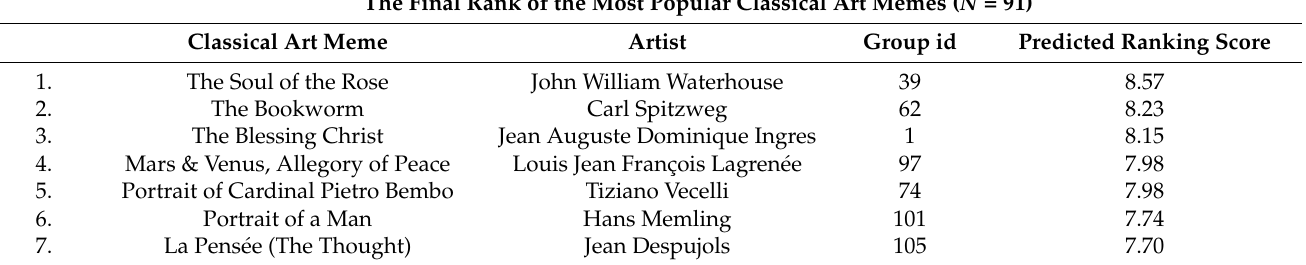
Table 5. The top 7 of the most popular classical art memes by ranking outcomes. The Final Rank of the Most Popular Classical Art Memes ( N =